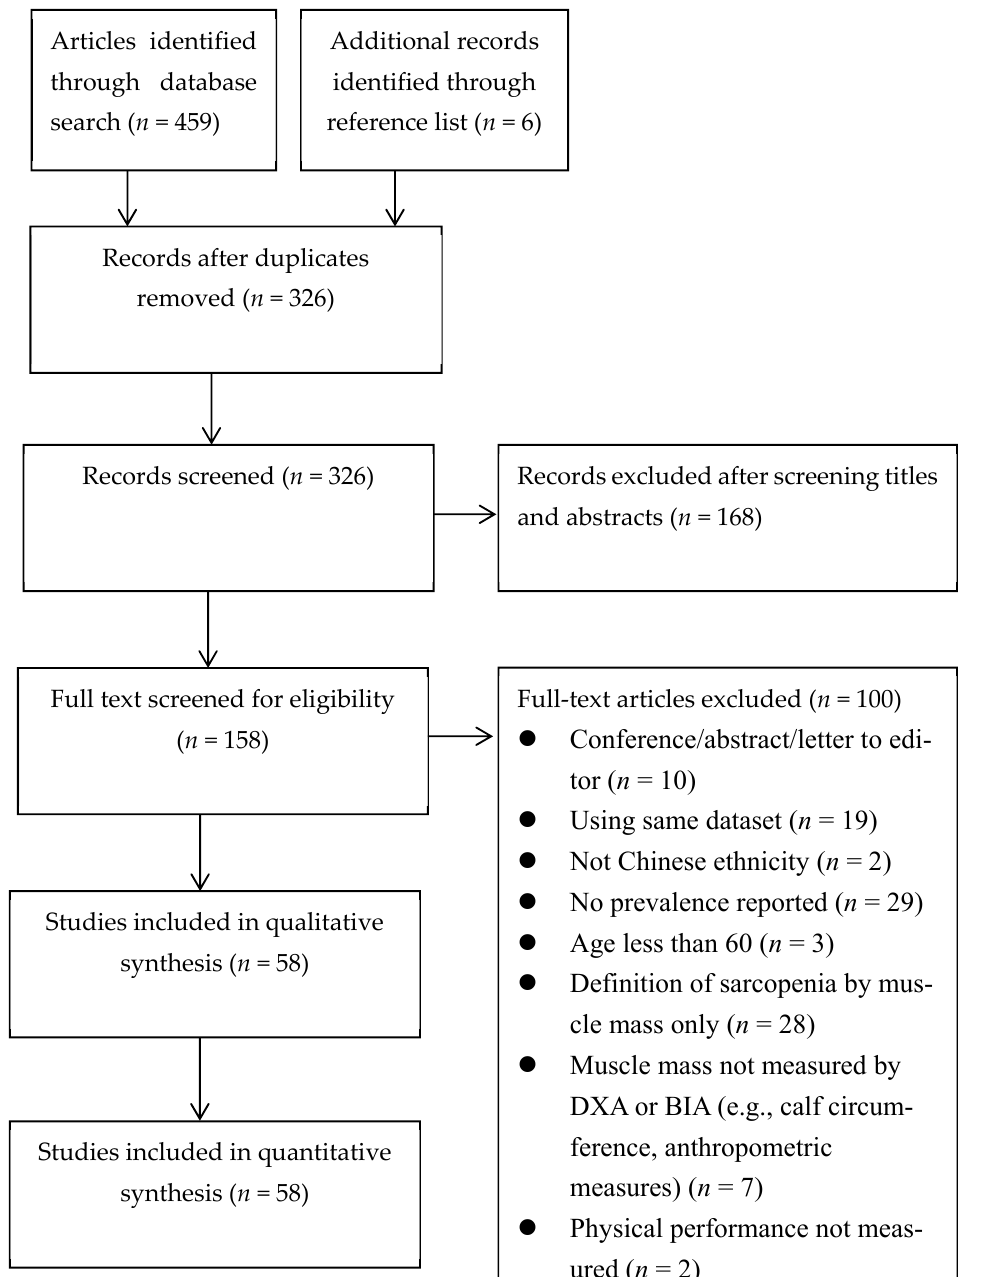
Figure 1. PRISMA Figure 1. PRISMA flowchart